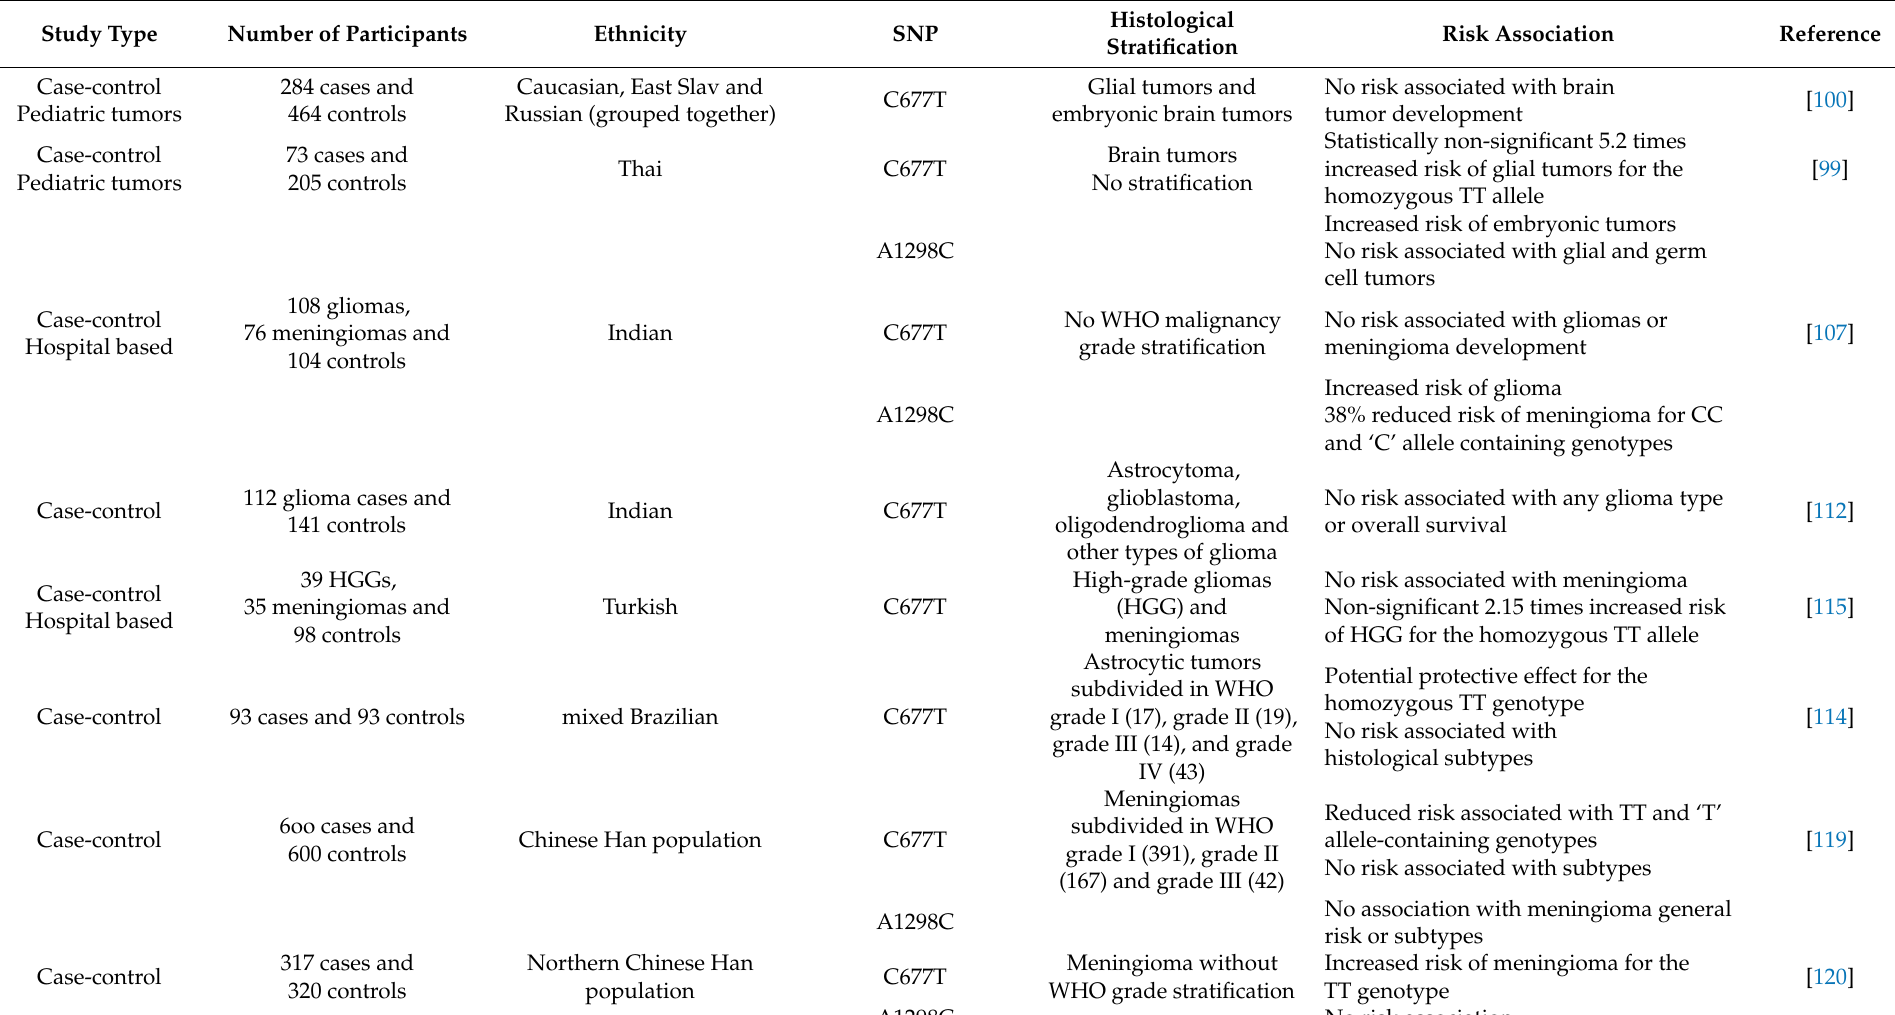
Table 2. Effect of the polymorphisms on brain tumor